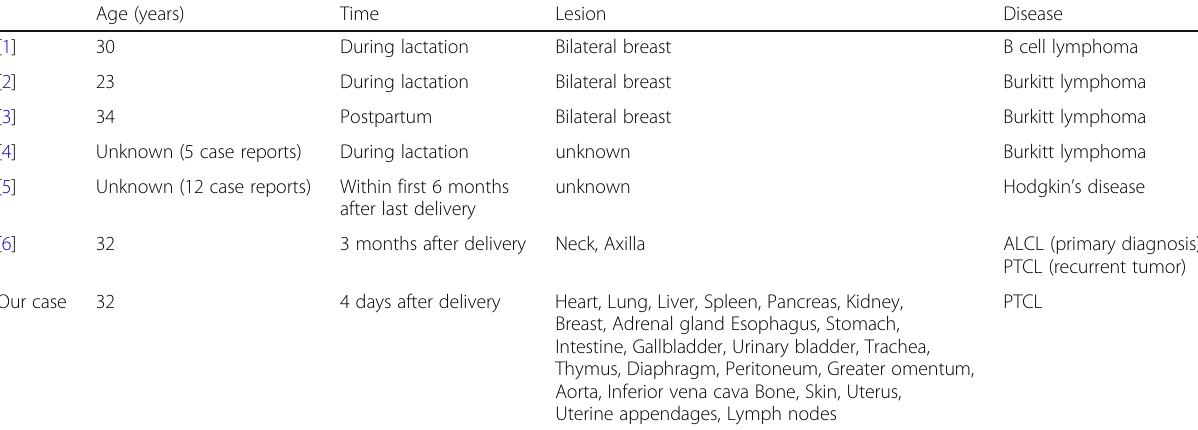
Table 1 The clinical characteristics of patients with lymphoma after delivery